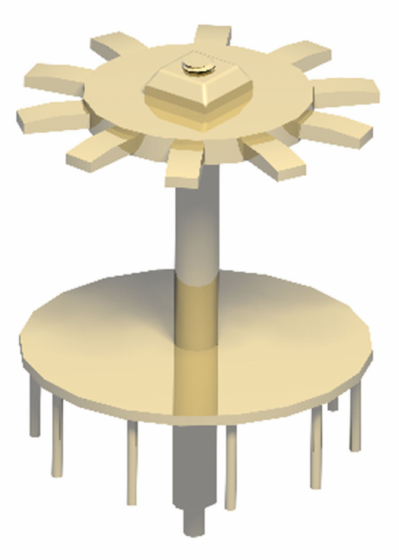
Figure 7. Input sub-assembly.